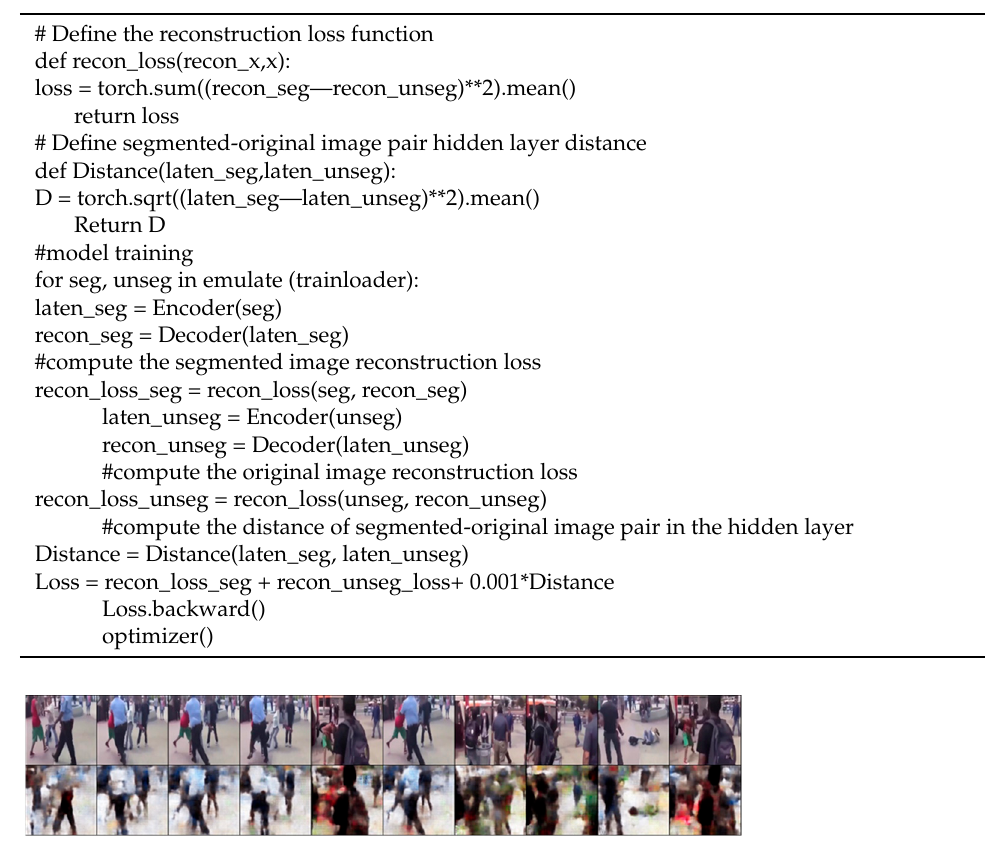
Table 4. Implementation of the model.